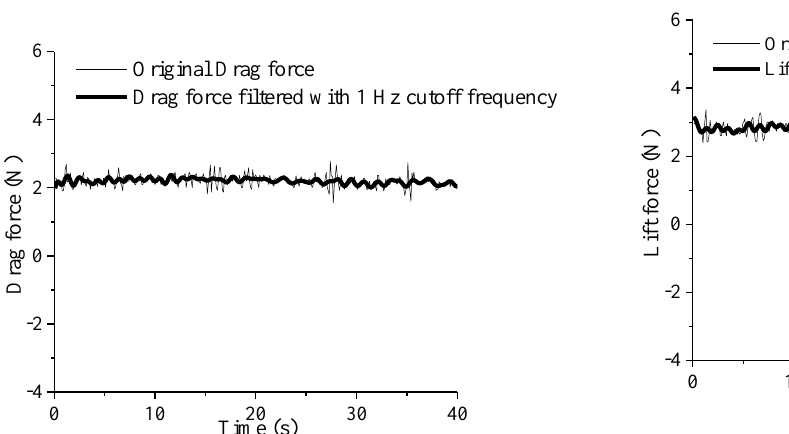
Figure 14. Time histories of the aerodynamic forces in conditions of viaduct highway and no end plates, at a wind attack angle of 30°.